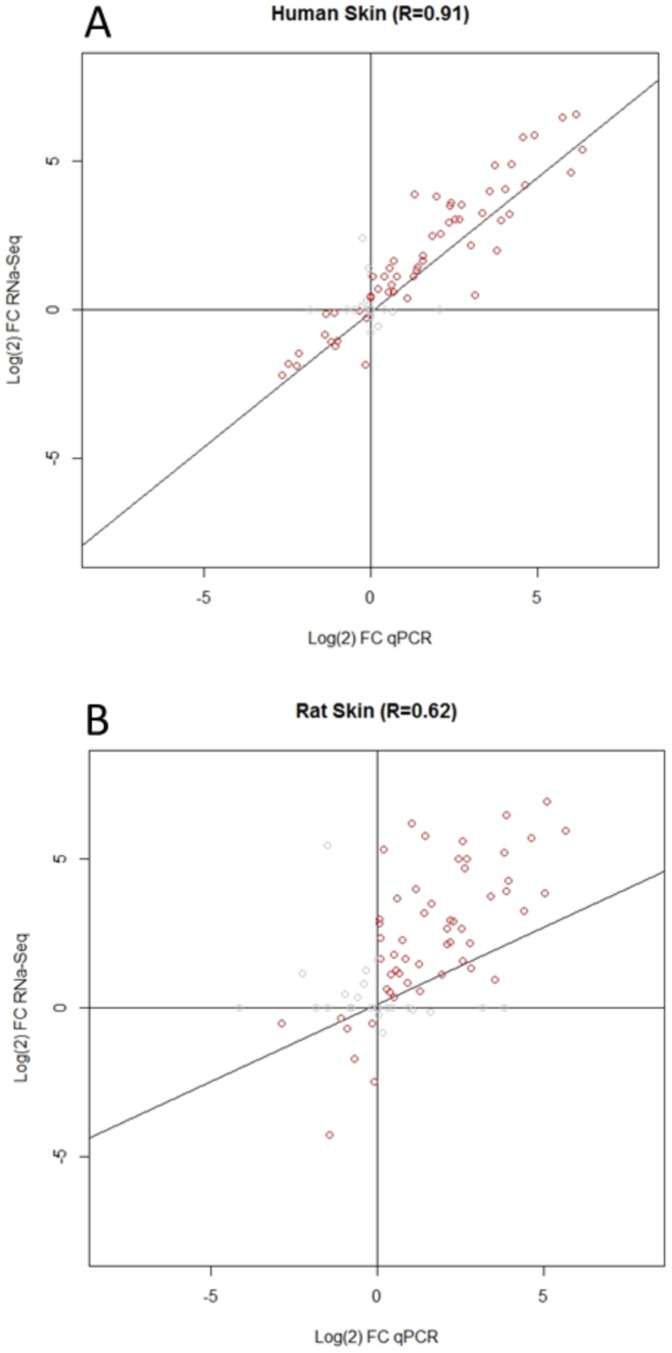
RNA-seq versus qPCR array correlation in the human and rat UVB models.To validate the changes seen using RNA-seq, FC values were correlated against those generated with qPCR array cards (previous data Dawes et al 2011). In both human (A) and rat (B) the Pearson's correlation coefficient (r = 0.911 and 0.620 respectively) showed that there was a positive correlation between the RNA-seq and qPCR array data for both species. These correlations were both highly significant (P<0.001), human n = 92 genes, rat n = 87 genes.